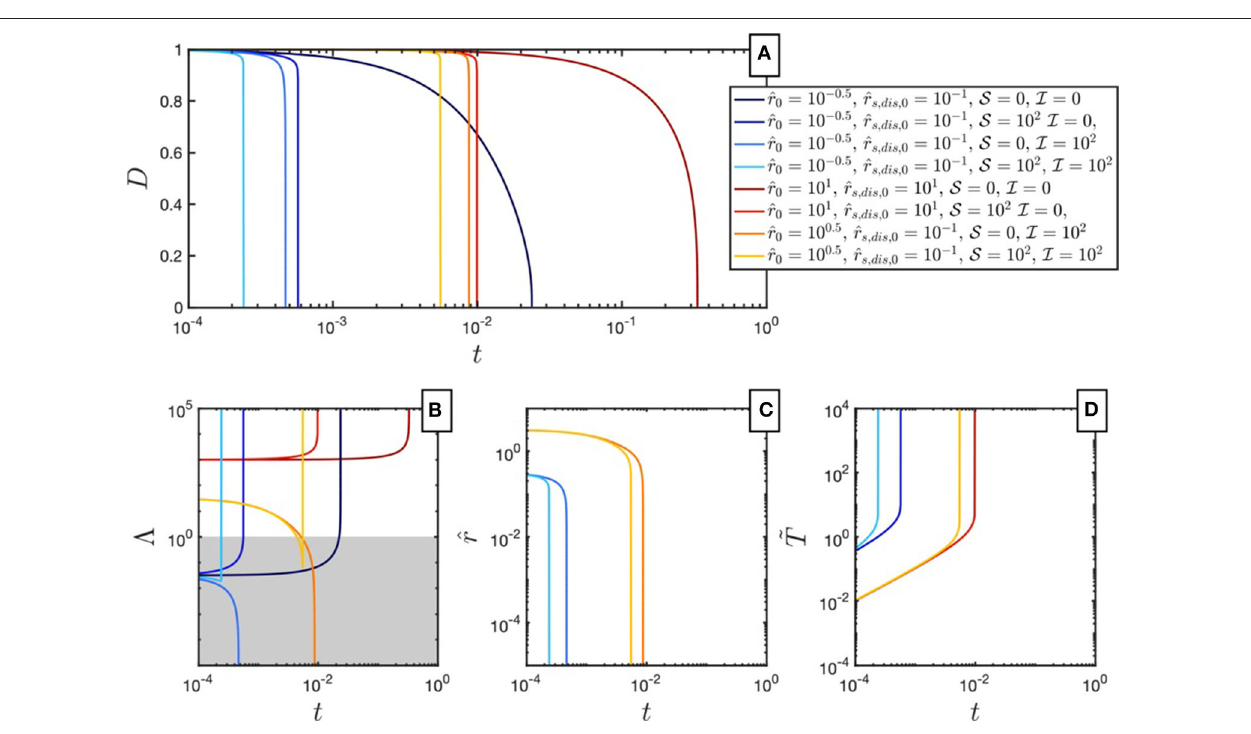
r 0 , r s , dis ,0 , S and I . (A) Evolution of neck thickness D . (B) Evolution of 3 ˆ ˆ